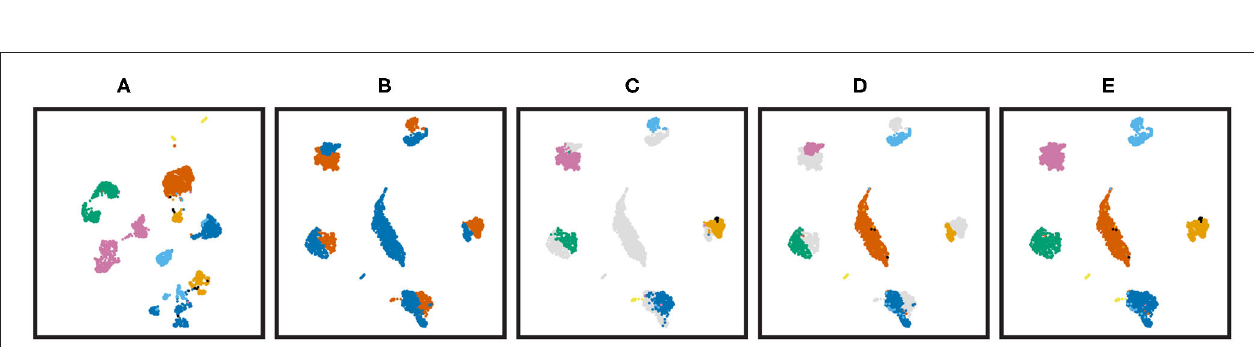
FIGURE 6 | UMAP visualization of imbalanced CBA for the pancreas datasets. alpha cells are removed from smartseq 2 and they are present in celseq 2. (A) The UMAP visualization of both batches when no alignment of the cells is performed and cells are colored according to batches. (B–E) Show the CBA performance: (B) colored according to batches, (C) colored according to the clusters found in batch one, (D) colored according to the clusters found in batch two, (E) colored according to the clusters found in both batches. The cluster colors are corresponding with Figure 2